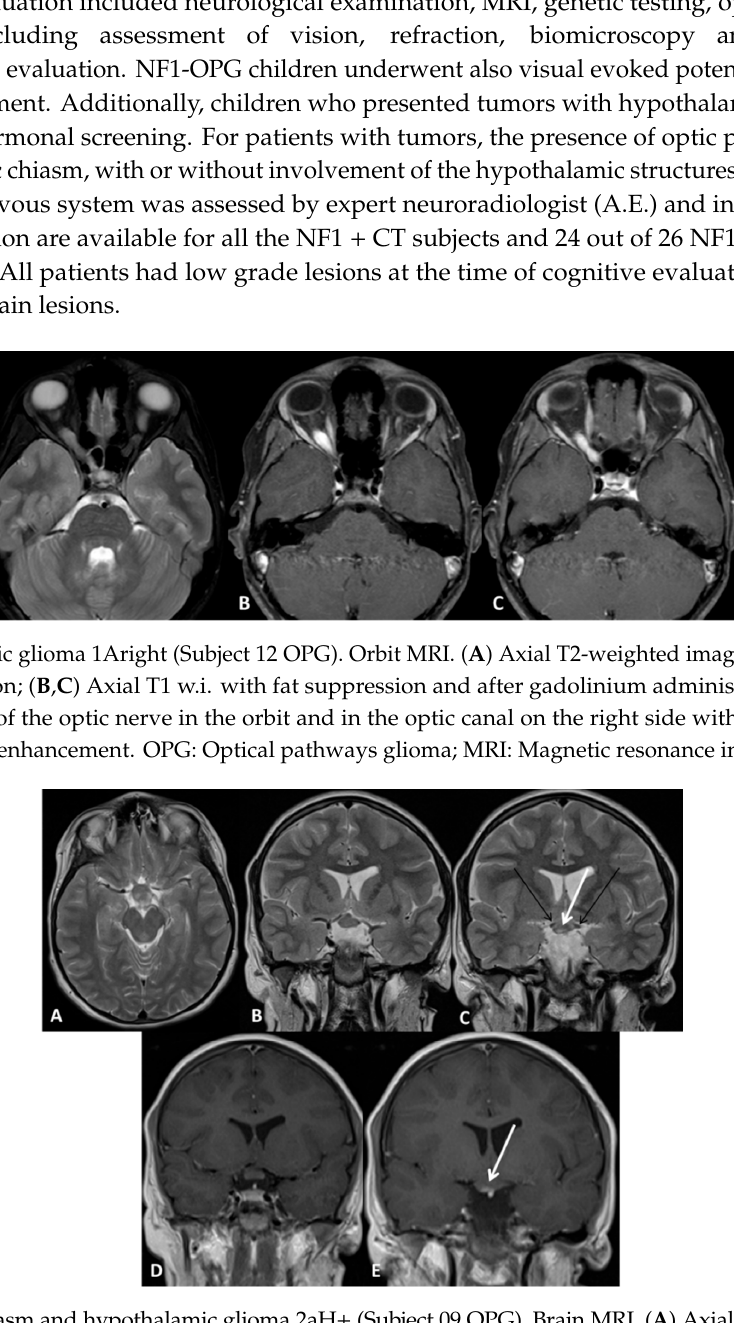
Figure 2. Chiasm and hypothalamic glioma 2aH + (Subject 09 OPG). Brain MRI. ( A ) Axial T2 weighted images(w.i);( B , C )CoronalT2w.i. ( B , C